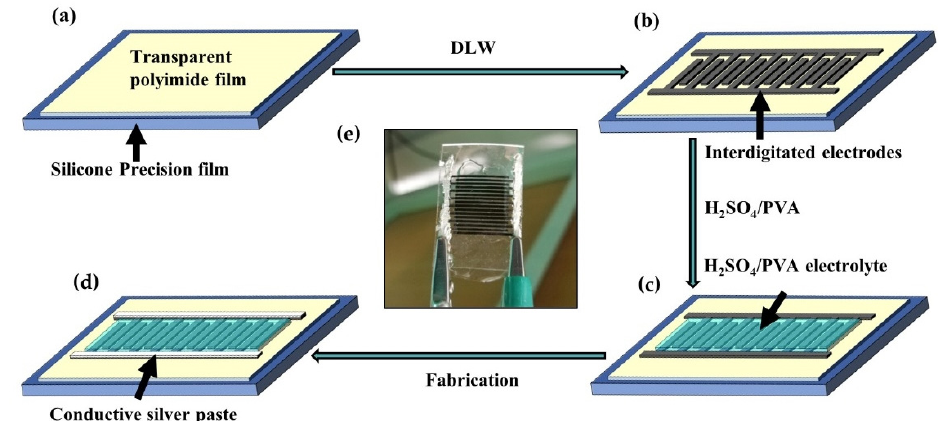
Figure 1. Schematic illustration of fabrication process of ( a – d ) supercapacitor and ( e ) is physical image of supercapacitor.